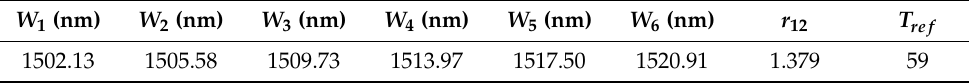
Table 2. Example of an observation of the synthetic dataset of filter